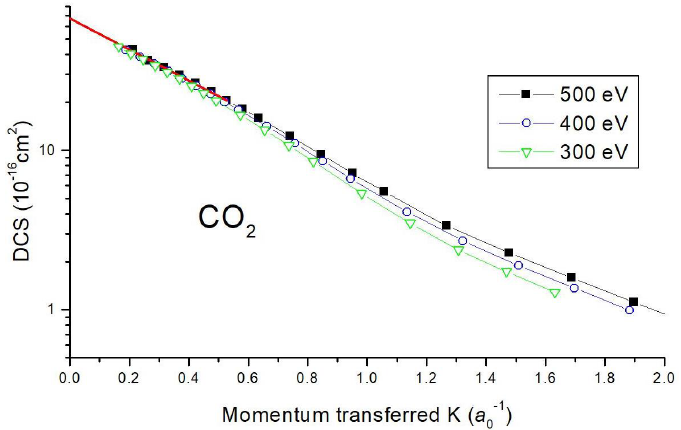
Figure 8. In search of the forward Born amplitude. Do DCSs at high energies tend to a constant value? Data for CO 2 are by Bromberg [69]; a single point for 10 ◦ at 400 eV by Iga et al. [81] coincides with Bromberg’s